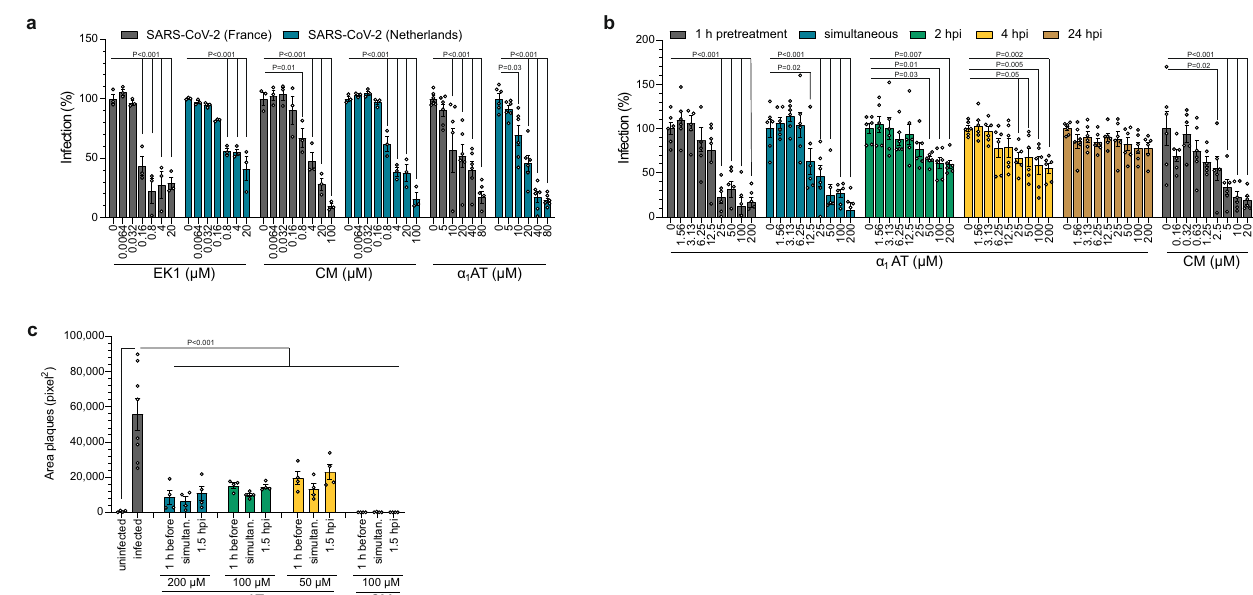
Fig. 3 α 1 AT inhibits SARS-CoV-2 infection and replication. a TMPRSS2-expressing Vero E6 cells were treated with Prolastin ( α 1 AT), EK1 or camostat mesylate (CM) for 1 h, and infected with SARS-CoV-2 isolates either from France (gray) or the Netherlands (blue) at a MOI of 0.001. Virus-induced cytopathic effects were assessed at 2 days post infection by MTS assay (see Supplementary Fig. 4 a, b for raw and cell viability data). b TMPRSS2- expressing Vero E6 cells were treated with Prolastin ( α 1 AT) at indicated timepoints prior to, simultaneously with or post infection with SARS-CoV-2 at a MOI of 0.001. Camostat mesylate (CM) control was added 1 h prior to infection. Infection rates were assessed at 2 days post infection by MTS assay (see also Supplementary Fig. 5a, b for raw and cell viability data). c TMPRSS2-expressing Vero E6 cells were treated with Prolastin ( α 1 AT) or CM 1 h prior to, simultaneously with or 1.5 h post infection with SARS-CoV-2. At 1.5 h post infection cellulose overlay was performed. At 2 days post infection, cells were stained with crystal violet (see Supplementary Fig. 6a, b) and plaque areas were quanti fi ed. The mean ± SEM from n = 1 ( a , EK1 and CM) or n = 2 independent experiments in biological triplicates ( a , α 1 AT, b ) or duplicates ( c ) and quadruplicates ( c , infected) are shown. (2-way ANOVA with Dunett´s multiple comparison test ( a , b ), ordinary one-way ANOVA with Dunett´s multiple comparison test ( c )). Source data are provided as a Source data fi α AT inhibits SARS-CoV-2 replication in primary human 1 airway cells . To corroborate the antiviral activity of α 1 AT in human primary target cells, we used small airway epithelial cells (SAECs) that support low level SARS-CoV-2 replication. For this, SAECs pretreated with buffer only (PBS), 80 µM of α 1 AT, or 100 µM of CM were infected with a high dose (MOI of 1) of infection to PBS pretreated cells. Cells were cultivated in the copies in supernatants were quanti fi ed by RT-qPCR. As shown in Fig. 4a, CM and α 1 AT present during infection reduced viral titers by ~92 and 83 %, respectively. α 1 AT that was added 3 and 24 h post infection also inhibited viral replication, albeit to a lesser extend (67 and 58 % reduction, respectively). We next